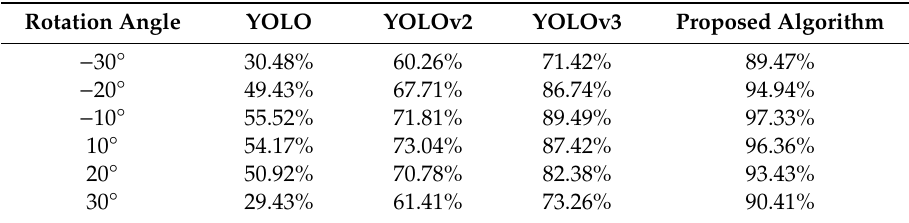
Table 4. mAP at different rotation angles. Table 4. mAP at di ff erent rotation